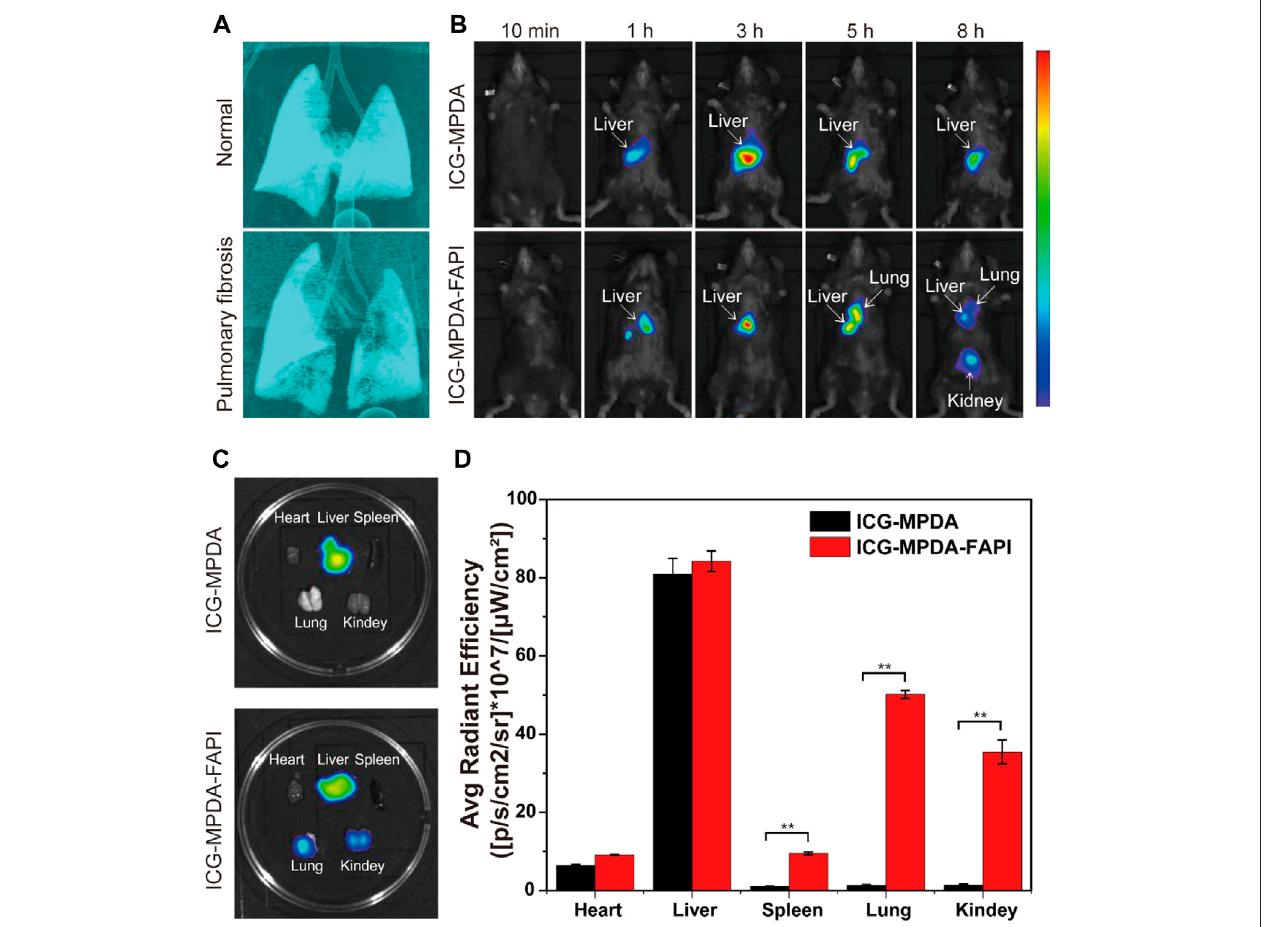
FIGURE5|(A) 3DCTofthenormallungandpulmonary fi brosis. (B) ICG-MPDAandICG-MPDA-FAPINIR fl uorescenceimaging invivo ofpulmonary fi brosismice. (C) ICG-MPDAand ICG-MPDA-FAPINIR fl uorescence imagingofpulmonary fi brosismice in vitro . (D) ICG-MPDA and ICG-MPDA-FAPINIR fl uorescence quanti fi cation of pulmonary fi brosis mice in vitro